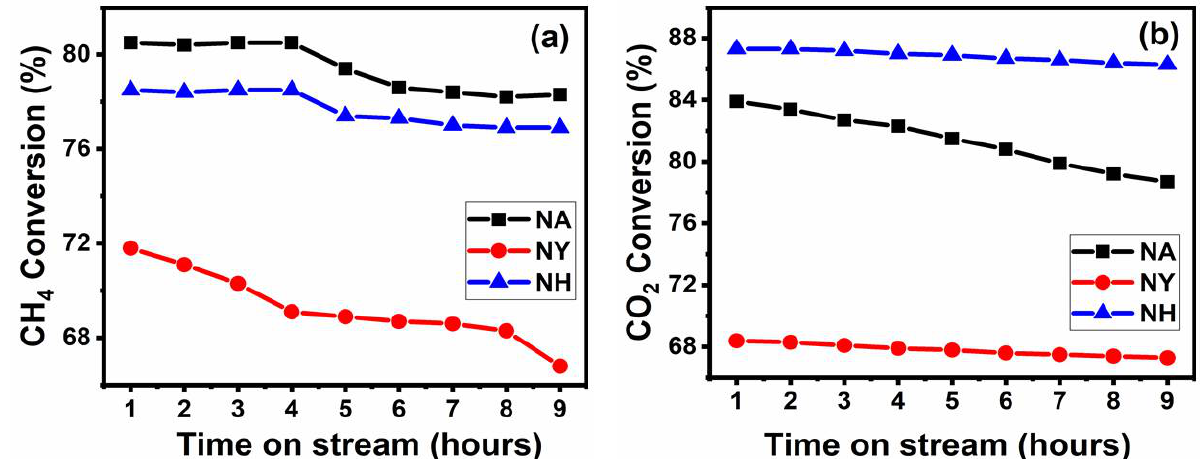
Figure 2. ( a ) CH 4 and ( b ) CO 2 conversion versus time on stream for Ni supported on alumina (NA), Ni supported on Y-zeolite (NY), and Ni supported on H-ZSM-5 (NH) catalysts. Table 1. Performance of NA, NY, and NH catalysts in CO 2 reforming of methane after 9 h.